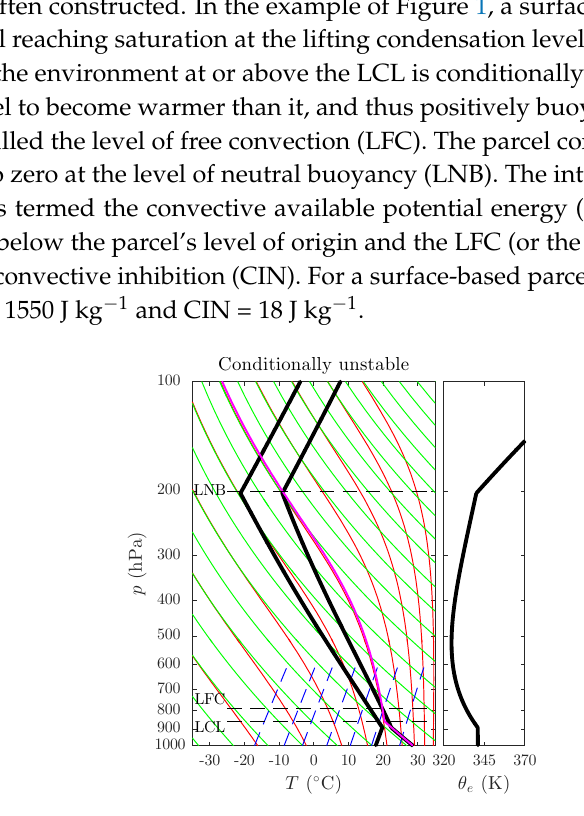
Figure 1. Left : skew-T/log-P diagram of a conditionally unstable environment [thick black lines show environmental T (right) and dewpoint T d (left)]. Green lines are dry adiabats, red lines are moist adiabats, dashed blue lines correspond to T d profiles of air with different saturation mixing ratios, and the thick magenta line is the path of an adiabatically lifted surface-based parcel. Right : corresponding profile of θ e . The environment is dry neutral up to 900 hPa and conditionally and potentially unstable from 900 to ∼ 500